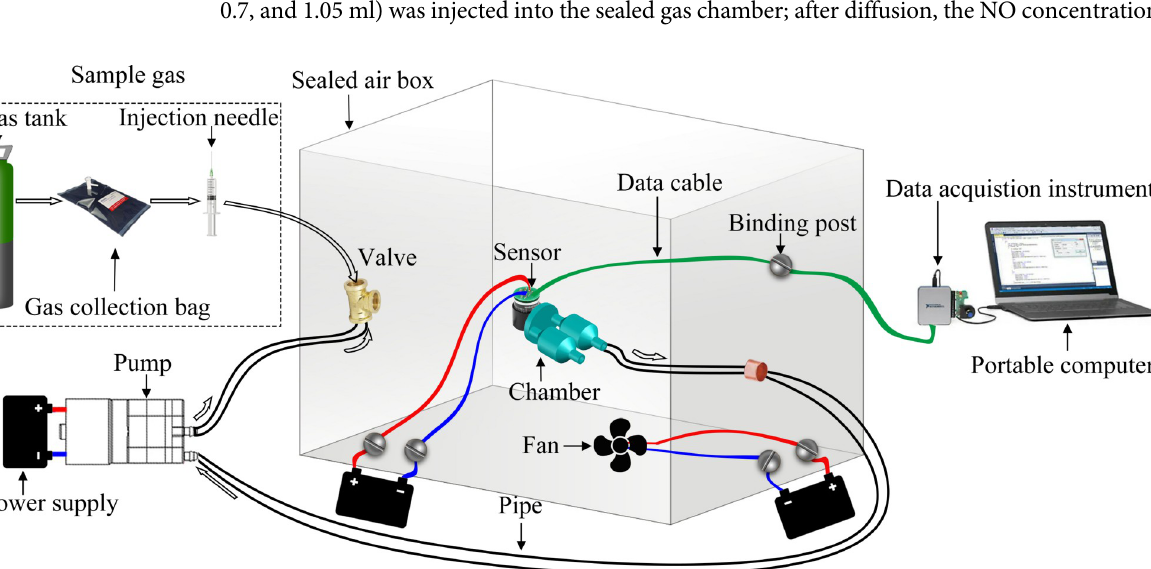
(B), pump suction flow (C), and error grade (D) of bionic Chamber.